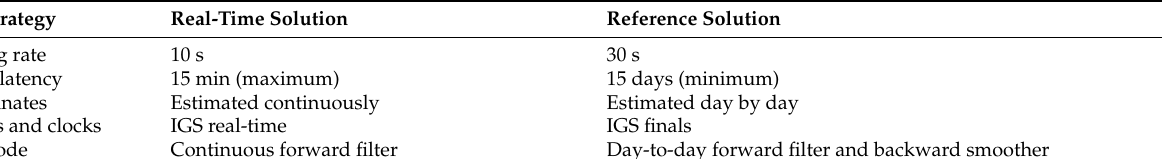
Table 1. Real-time and post-processing strategies and